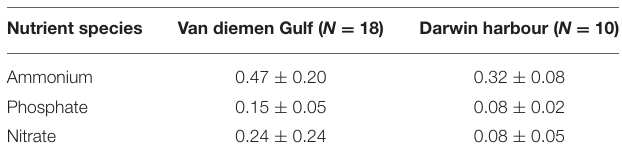
TABLE 4 | Nutrient budget for the two regions (in µ mol.L − 1 ) as sampled during the 2013 dry season field